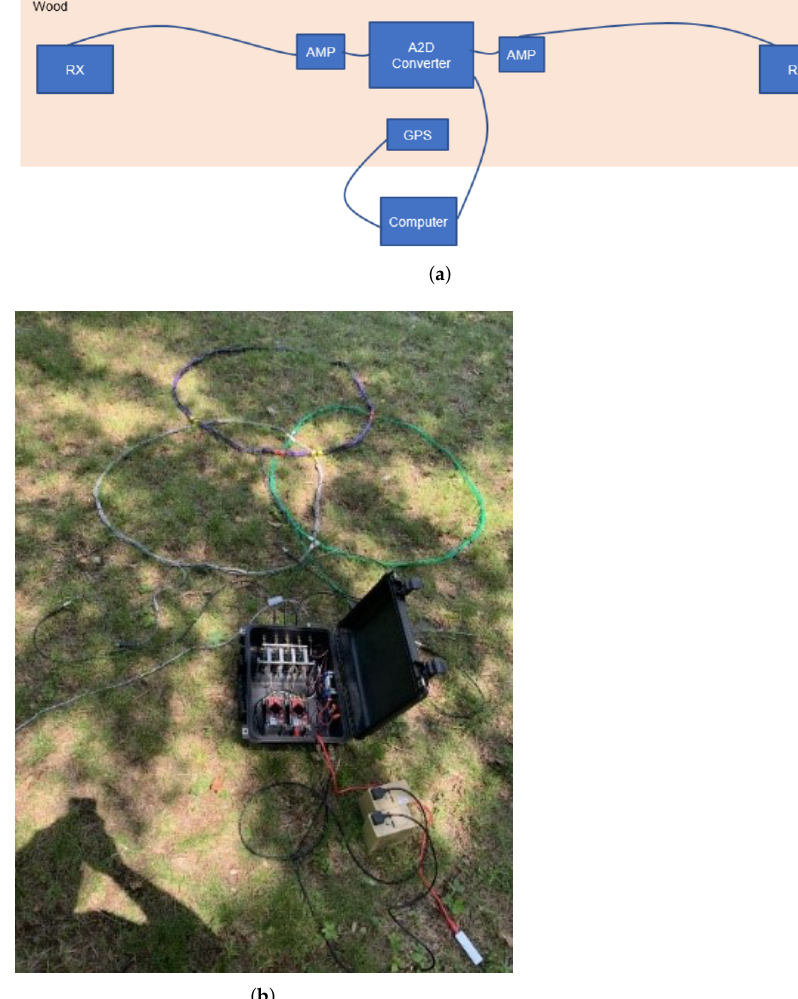
Figure 12. Sensor and dipole transmitter. ( a ) Block diagram of gradiometer sensor. ( b ) Simultaneous vertical magnetic dipole